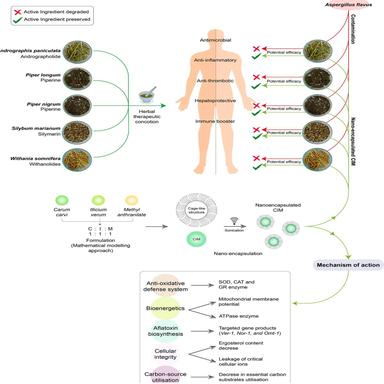
Schematic representation of nano-encapsulated antifungal formulation as shelf-life enhancer of herbal raw material and their active principles; and their mechanism of action.